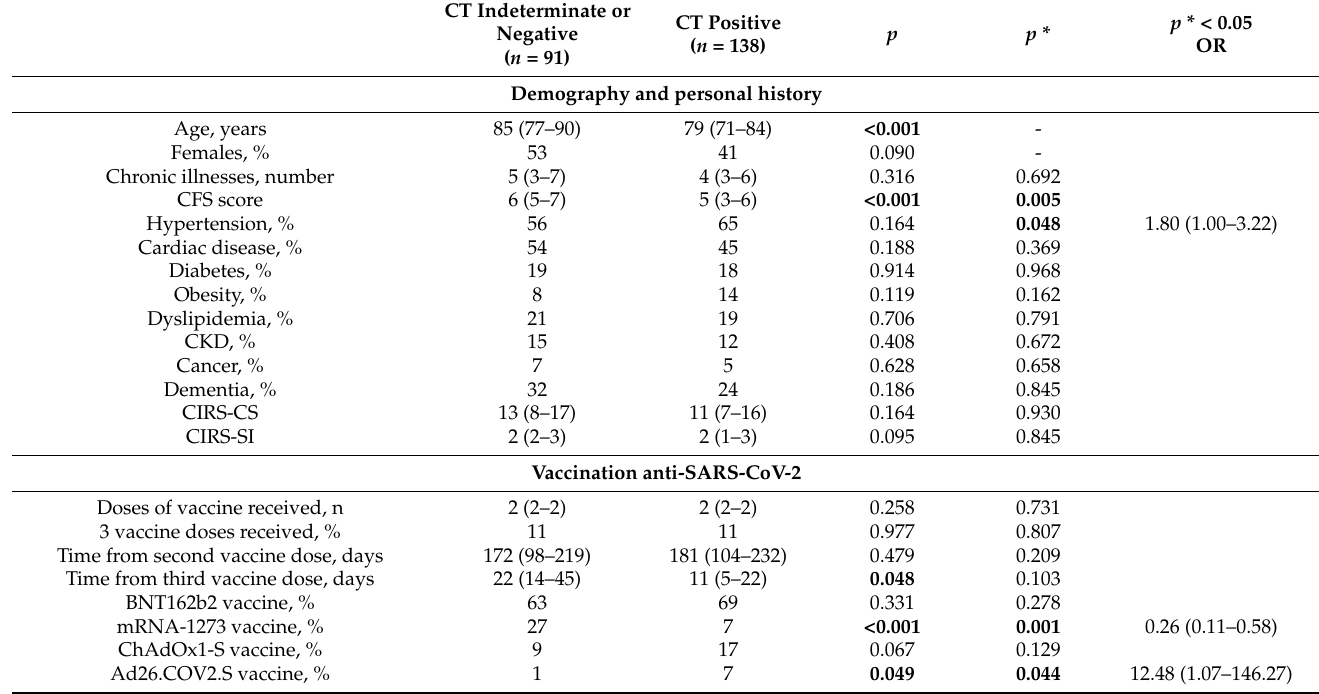
Table 1. Comparison of the clinical and laboratory characteristics and outcomes of patients with breakthrough infection categorized according chest CT